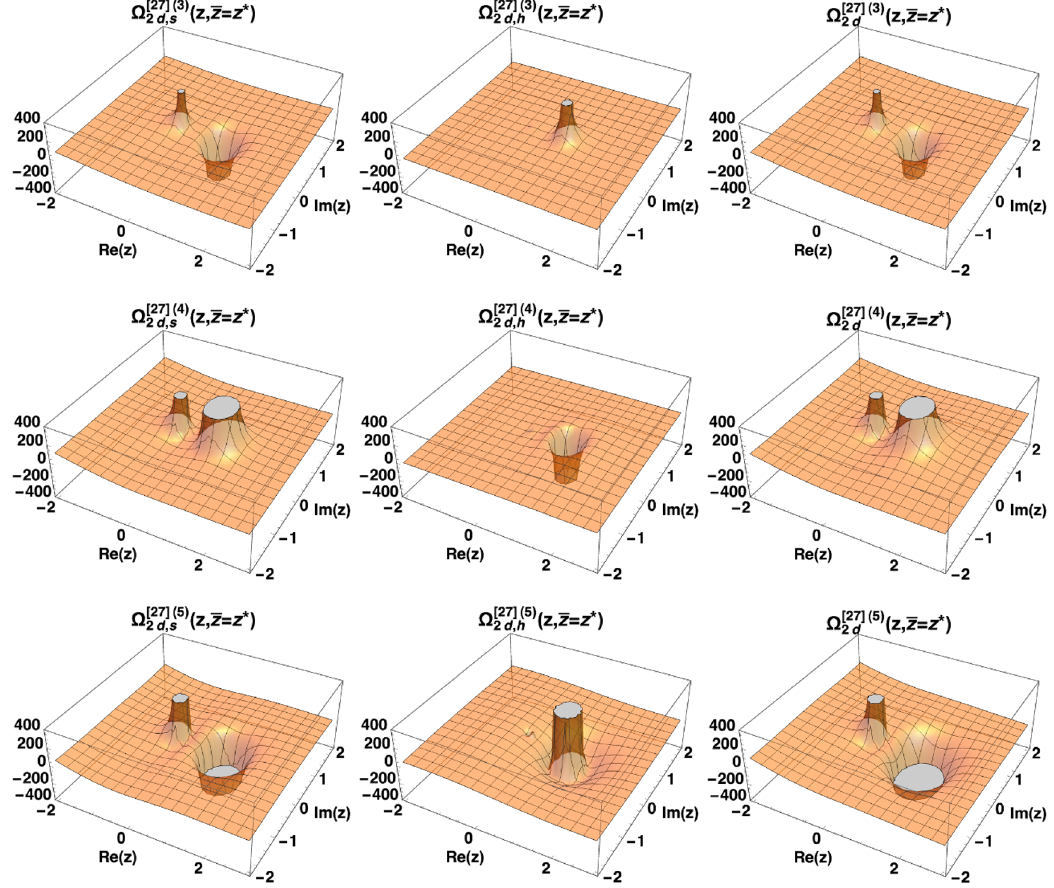
Figure 9 . Soft, hard and full wavefunction in the complex plane Re( z ), Im( z ). Here we plot the component corresponding to the 27 colour